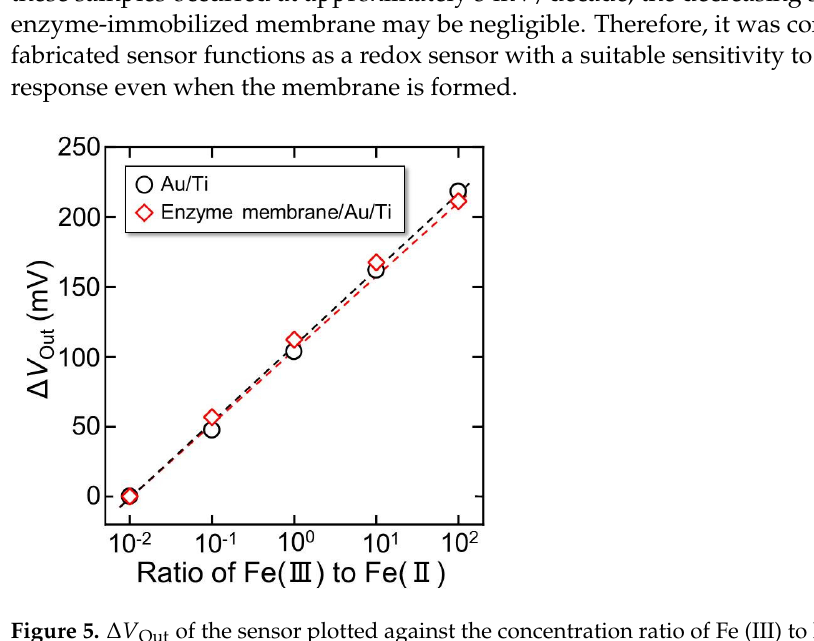
6 of 14 Figure 4 . Optical microscopic image of a redox-type label − free ATP image sensor. The sensor area for ATP detection is indicated with a black dash line. 3.2. Redox Response To confirm that the enzyme-immobilized sensor functions as a redox sensor, the po- tential change in the redox response was measured and compared to that of the sensor without an enzyme membrane. Figure 5 shows the relationship between the output volt-